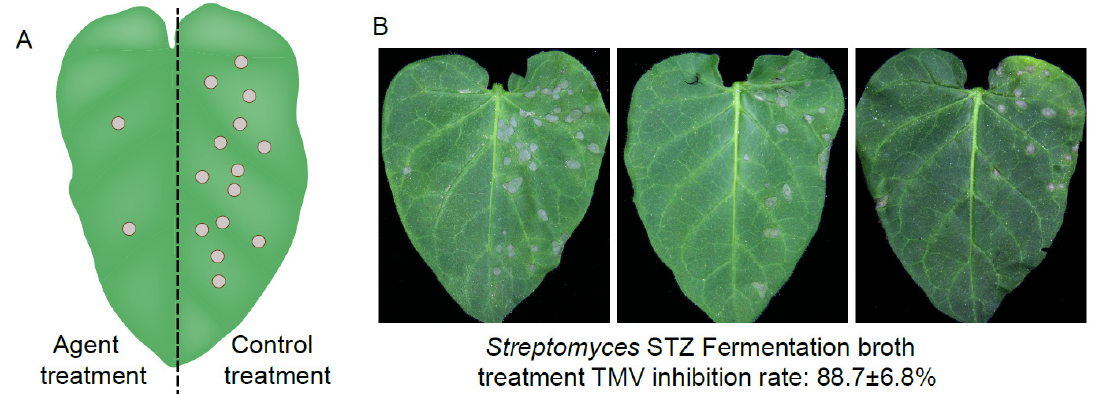
Figure 1. ( A ) Schematic representation of half-leaf method to study the anti-viral effect of the agent using N. glutinosa plants; ( B ) Inhibition effect of Streptomyces STZ fermentation broth against the TMV.